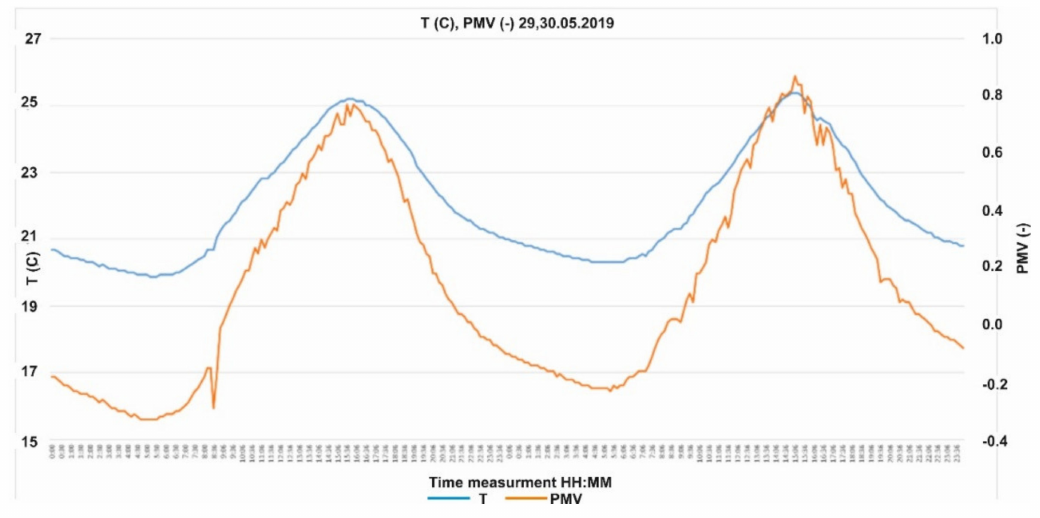
Figure 15. Indoor temperatures and Predicted Mean Vote (PMV) coe ffi